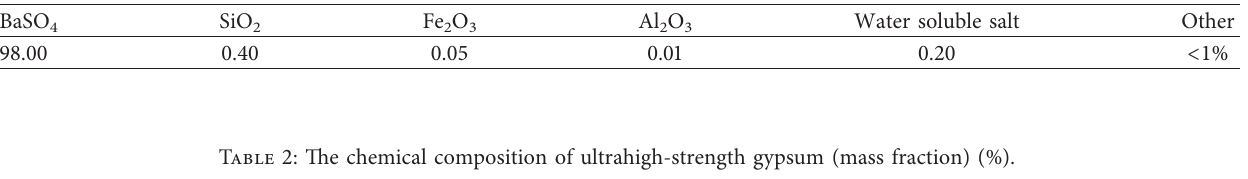
Table 1: The chemical composition of barite powder (mass fraction) (%).